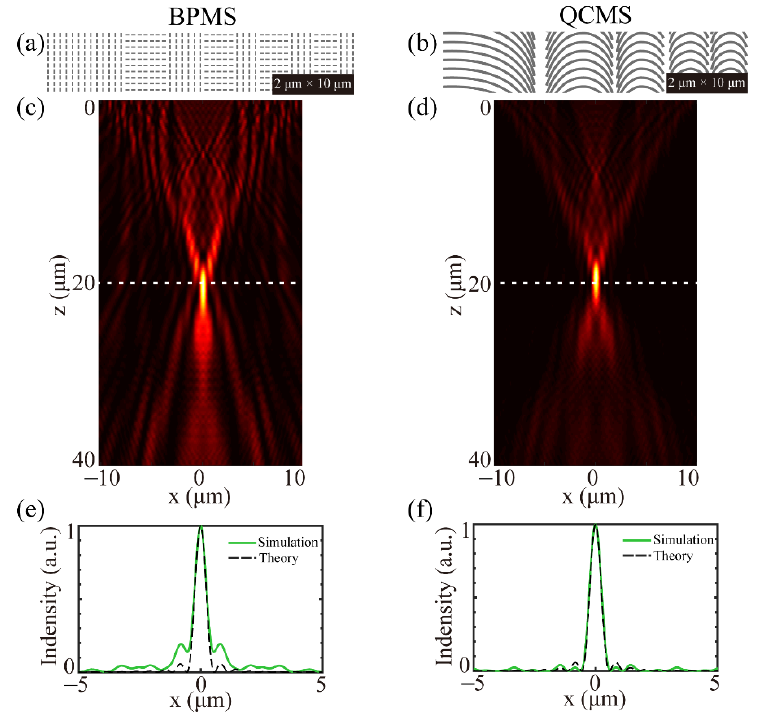
Figure 3. ( a , b ) Partial diagrams of BPMS and QCMS, respectively. Light fields of BPMS ( c ) and QCMS ( d ) along the propagating direction. ( e , f ) Corresponding normalized intensity curves along the white dotted lines in ( c , d ), where black dotted lines indicate the theory intensity curves.